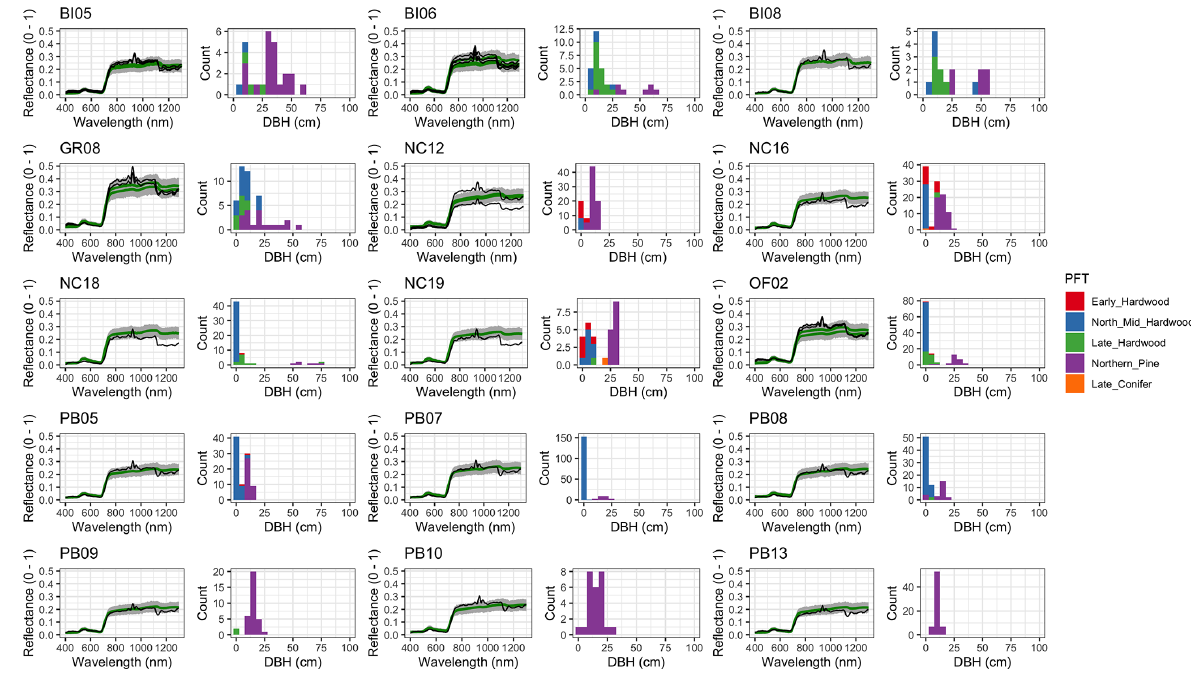
Figure A14. As above but for sites where pine trees had the largest mean